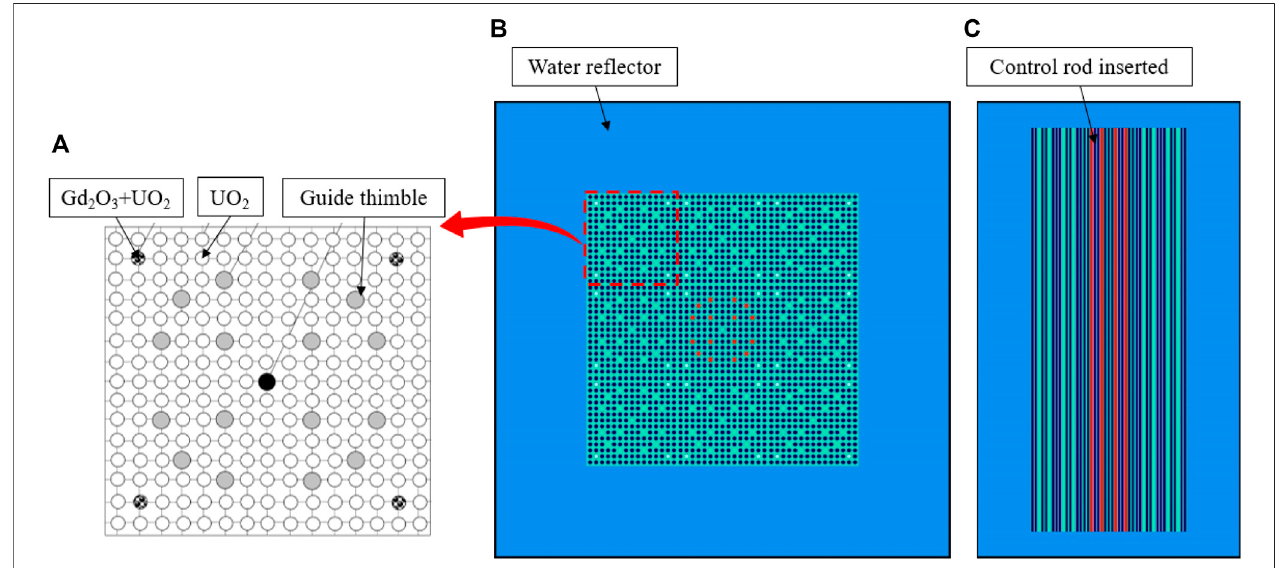
FIGURE 9 | TMI-1 mini-core fuel assembly (A) , x – y cut (B) , and x – z cut (C) (not to